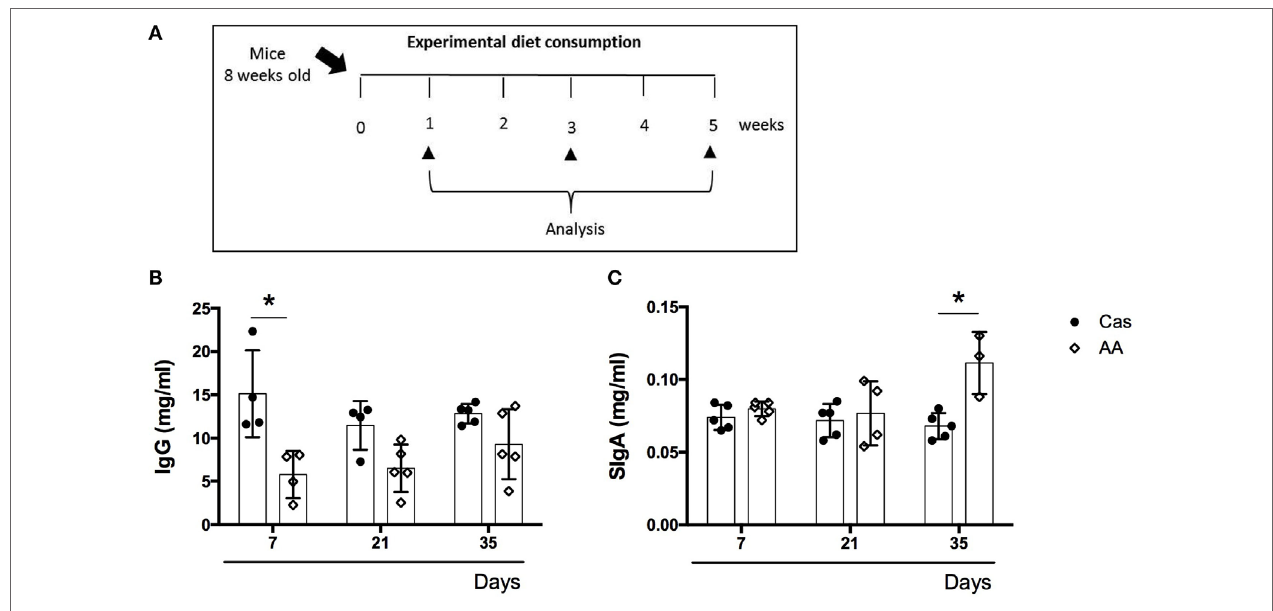
FigUre 1 | Effects of a diet containing free amino acids (AA diet) on immunoglobulin production. (a) C57BL/6 mice at 7–8 weeks of age were fed either experimental diet (AA diet) or control diet [casein-containing diet (CAS) diet)]. Administration of diets was maintained for 5 weeks. Levels of total serum immunoglobulins (b) and SIgA in the colon (c) were measured at the end of 7, 21, and 35 days of diet consumption by enzyme-linked immunosorbent assay (ELISA) ( n = 5). Statistical analysis was performed between CAS-fed and AA-fed group at the end of each experimental time point using Student’s t test for parametric data. p <